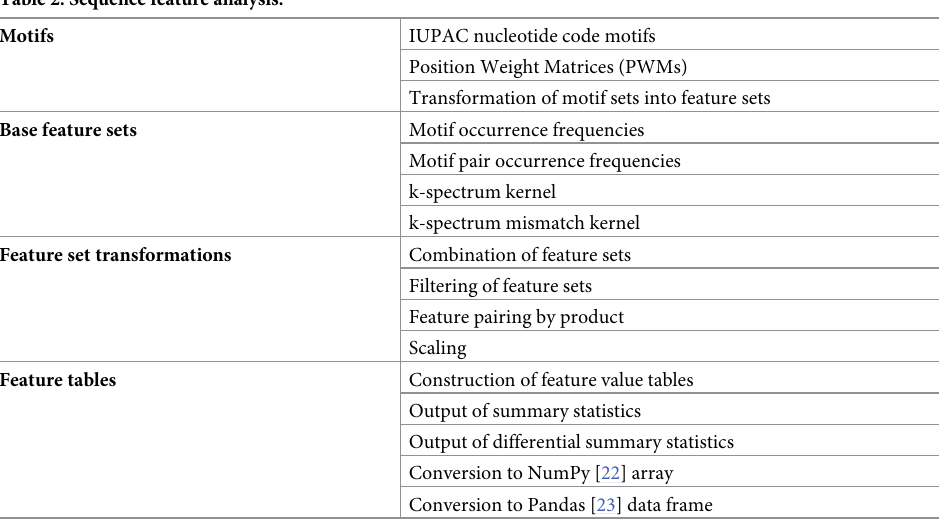
Table 2. Sequence feature